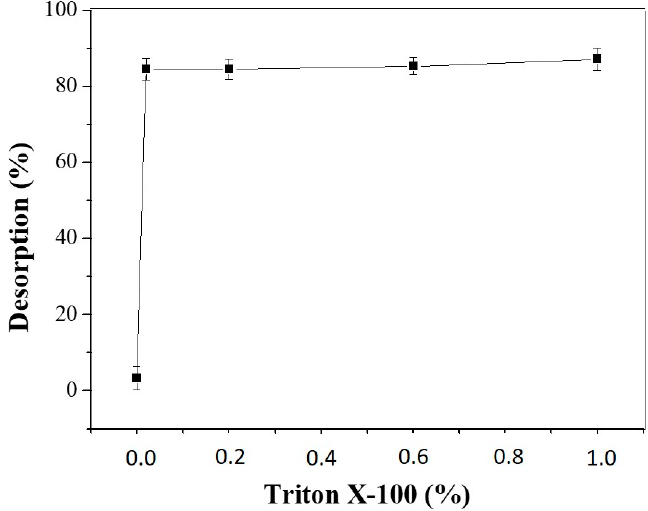
Figure 11. Desorption of the enzyme LU immobilized in CTA using Triton X-100 at concentrations of 0.02%, 0.2%, 0.5% and 1.0% ( v / v ). The error bars are derived from triplicates. 0.02%, 0.2%, 0.5% and 1.0% ( v / v ). The error bars are derived from